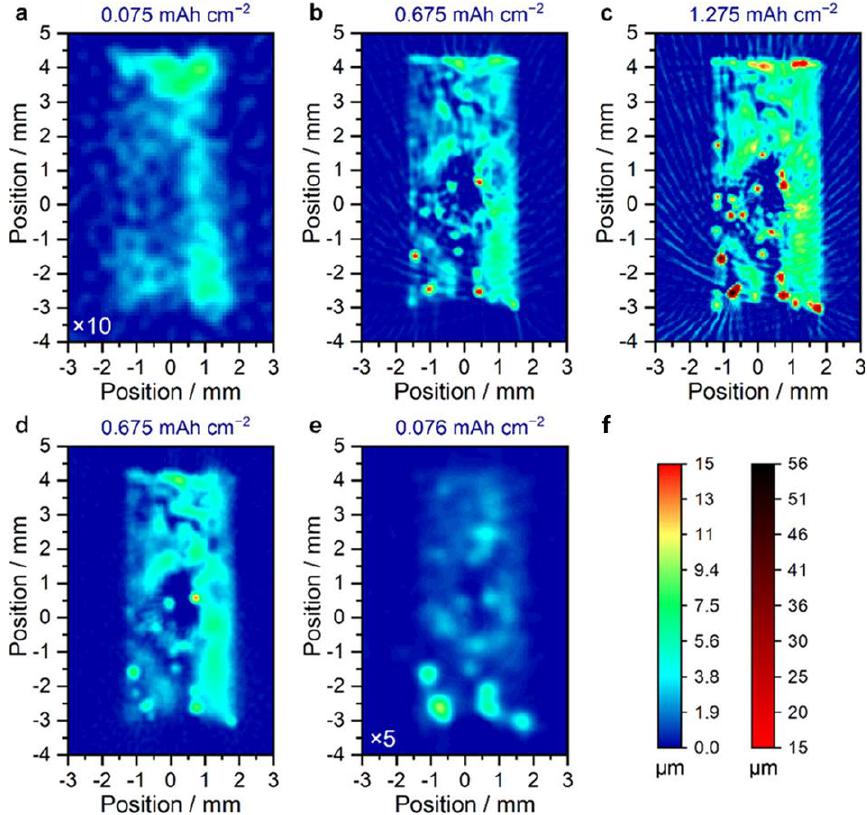
Figure 7. In situ EPRI for the first cycle of LCO||Cu cell. ( a – c ) Images at the end of three charging phases (1Ci, 1Cii, and 1Ciii); ( d , e ) images at the end of two discharging phases (1Di and 1Dii) (meas- ured at X band); and ( f ) color bars representing the thickness values of Li deposition. Reproduced with permission from ref. [67] . Copyright 2021, copyright American Chemical Society.